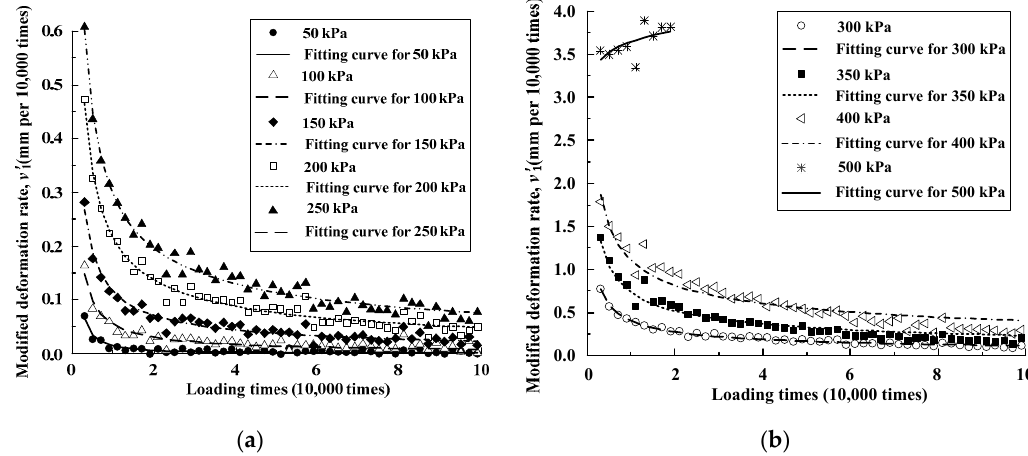
Figure 13. The relationship between modified deformation rate and loading times for Model 2 ( K = 0.95) when cyclic amplitude ranges from ( a ) 50 kPa to 250 kPa; ( b ) 300 kPa to 500 kPa.